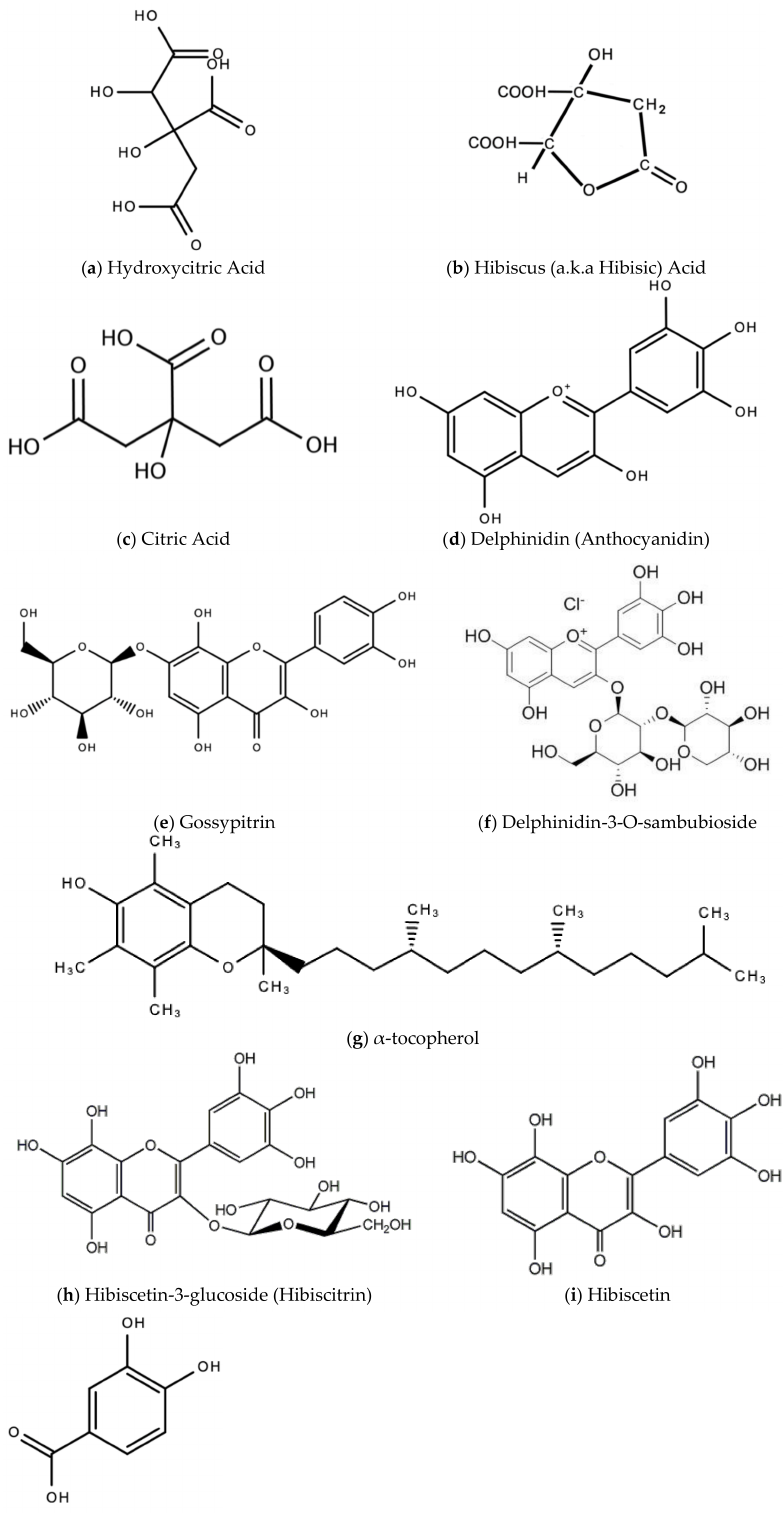
Figure 17. Chemical structures of some bioactive molecules found in